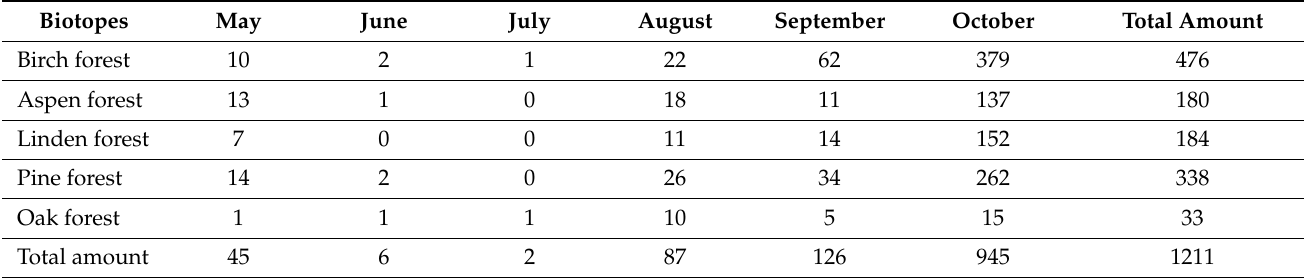
Table A2. Seasonal dynamics of Drosophila histrio in five biotopes.